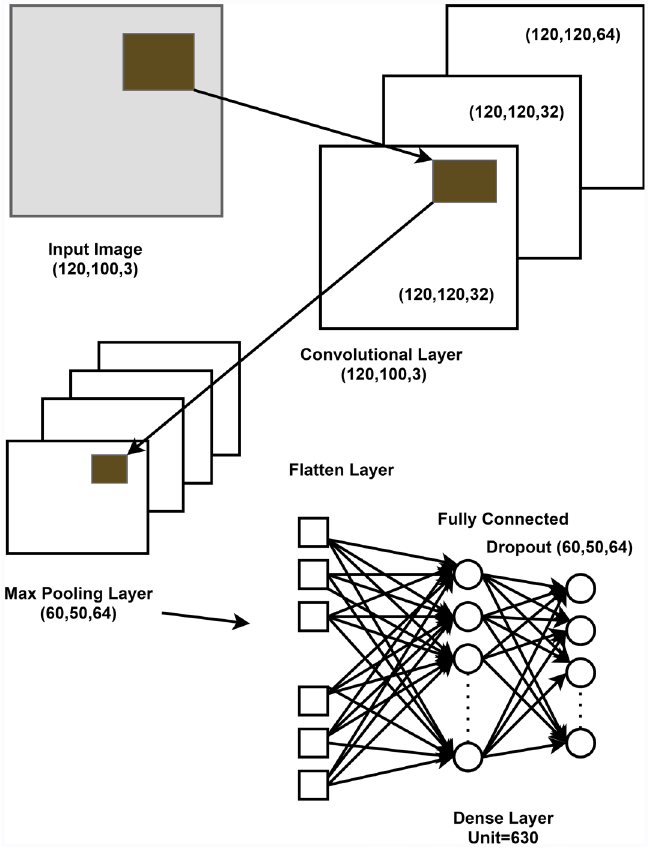
Figure 9. The architecture of the implemented CNN model.